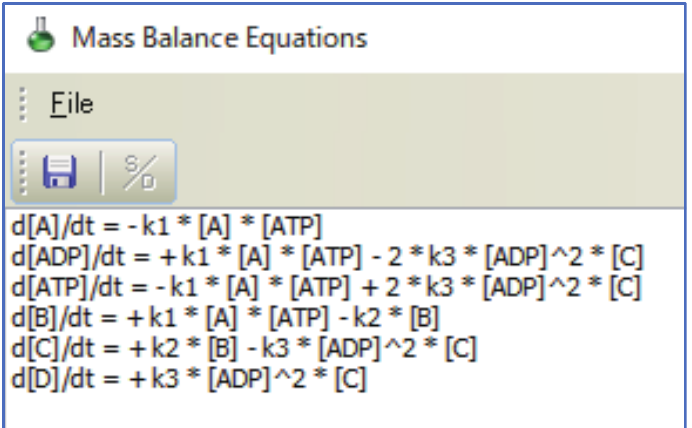
Figure 6. Reaction scheme corresponding to Figure 5 created using WinBEST-KIT.